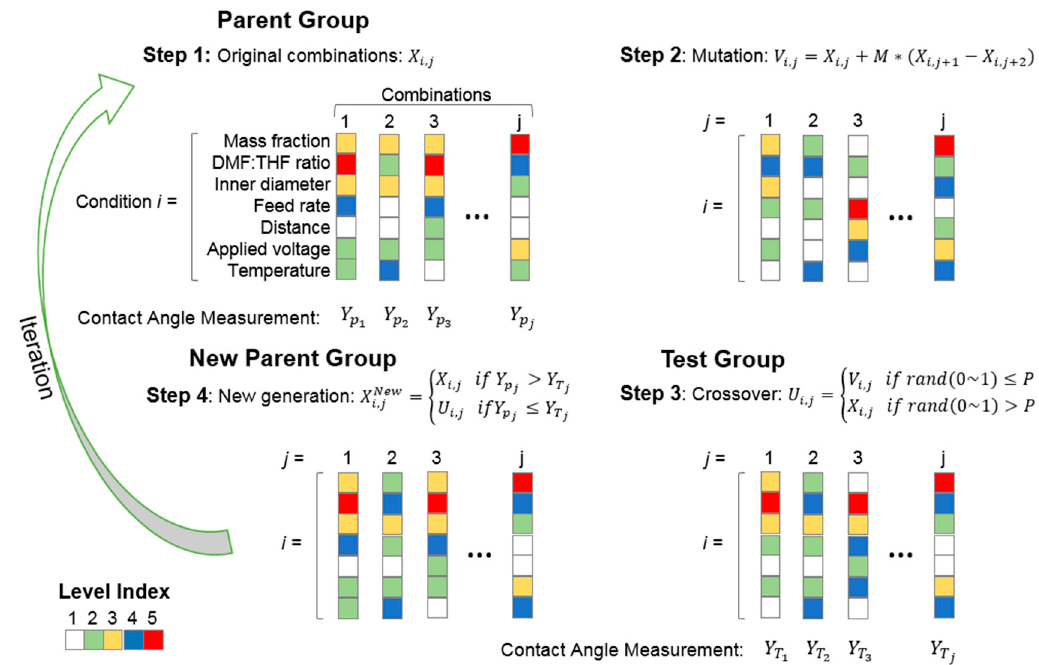
Figure A2. A schematic diagram of DE algorithm. The algorithm goes through four steps in each iteration of the experiments. ( 1 ) Generation of the parent group. In the first iteration, the parent group is not generated by the DE algorithm. Originally, a set of random combinations is often adopted, while in this study, we use the Latin Square design of experiments to improve the optimization efficiency. As shown in this diagram, the color of each square represents the level of the parameter, and each column represents a parameter combination. ( 2 ) Mutation is introduced to each square based on subsequent combinations with the Mutation Constant M. ( 3 ) Generation of test group by crossover with Crossover Constant P. For each square in the new test group, a random number is used to determine whether the mutation is reserved. After the crossover, the new test group is tested via experiment. ( 4 ) Generation of new parent group. The experimental result of each combination in the test group is compared with its according combination in the parent group, and the one with better performance is reserved for the new parent group. The output of step 4 will be the input of step 1 after the second iteration, and these steps loop until the optimal combination is found.